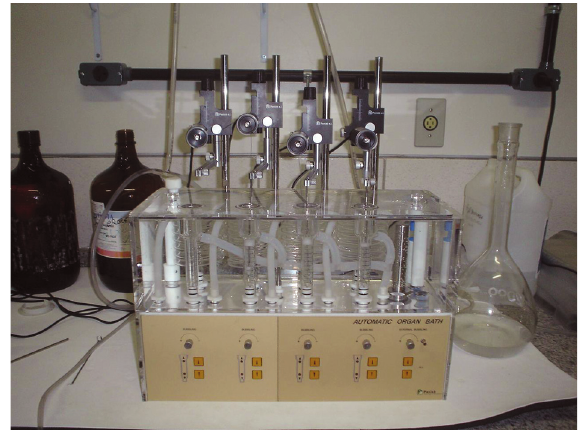
Figure 4 – Isolated bathing